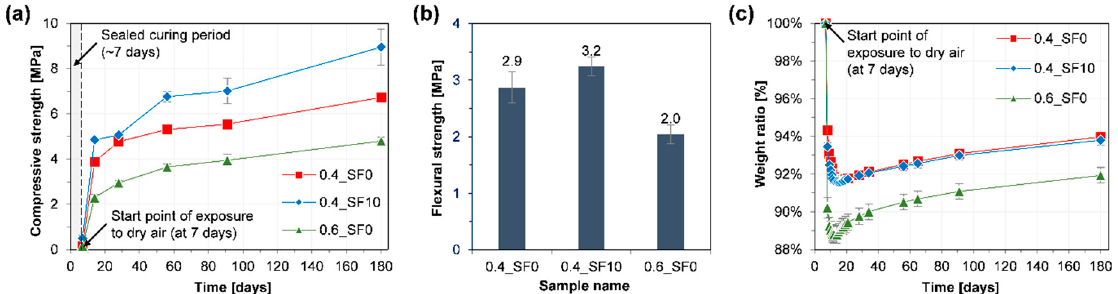
Figure 2. Properties of air lime mortar: ( a ) compressive strength development for 180 days, ( b ) flexural strength at 91 days, and ( c ) weight change for 180 days.